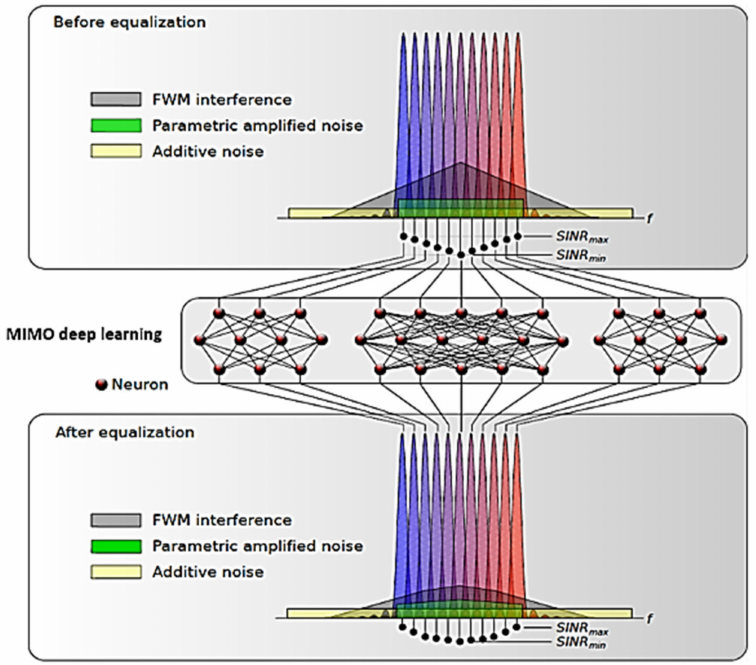
Figure 25. Conceptual diagram of the neural network-based MIMO equalization